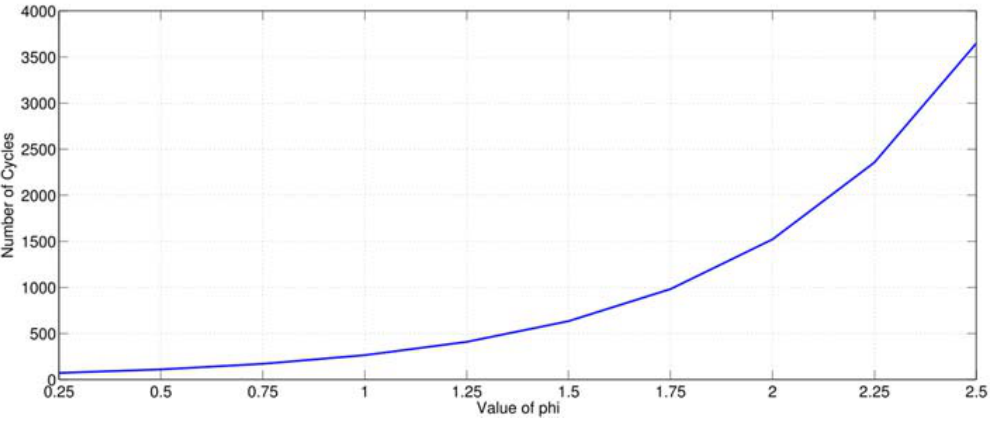
Figure 3. The impact of having different values for φ k on number of cycles.